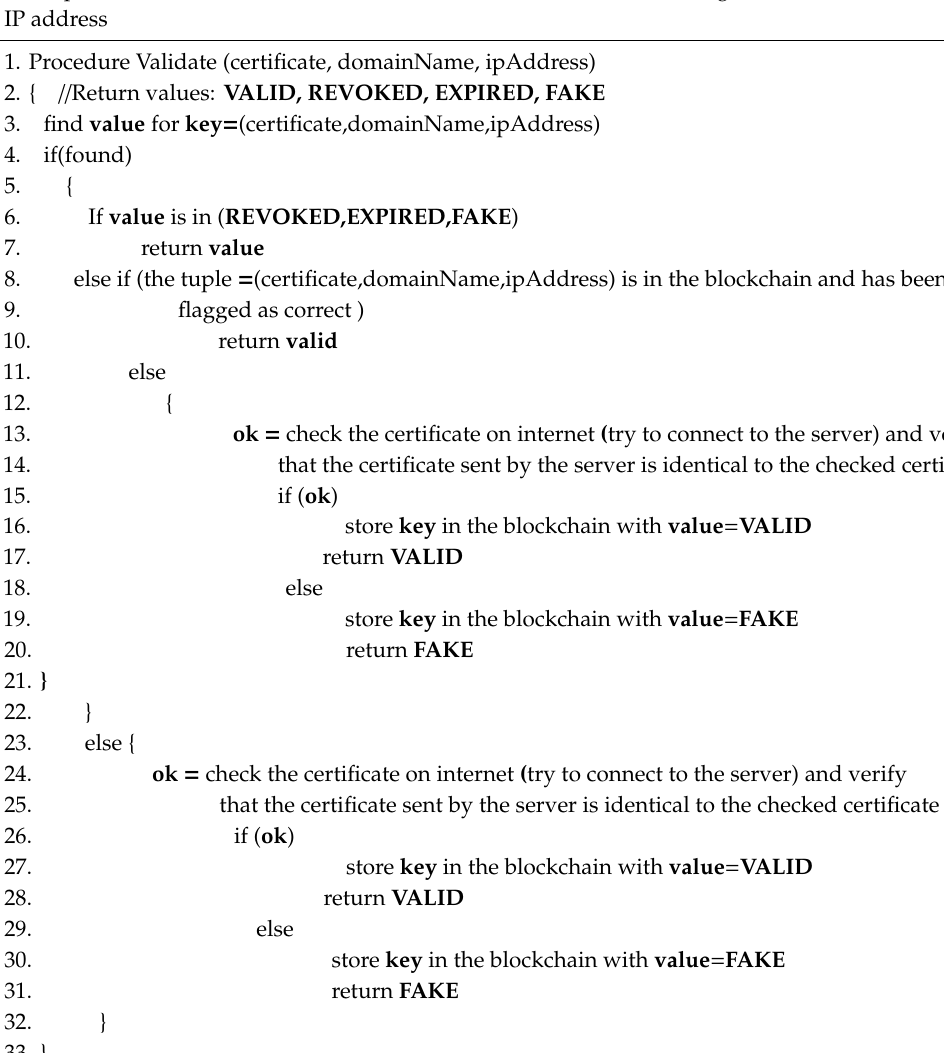
Algorithm 1 Pseudo code of the smart contract procedure used from a client to validate an X.509 certificate received in the starting phase of a TLS connection. It is important to note that the algorithm also manages the case of a new server and a new associated certificate when the CA and the server involved are not in the blockchain. In this case, the agreement comes from a smart contract that checks that many unrelated clients with sparse locations start the TLS connection with the same server using the same certificate and the